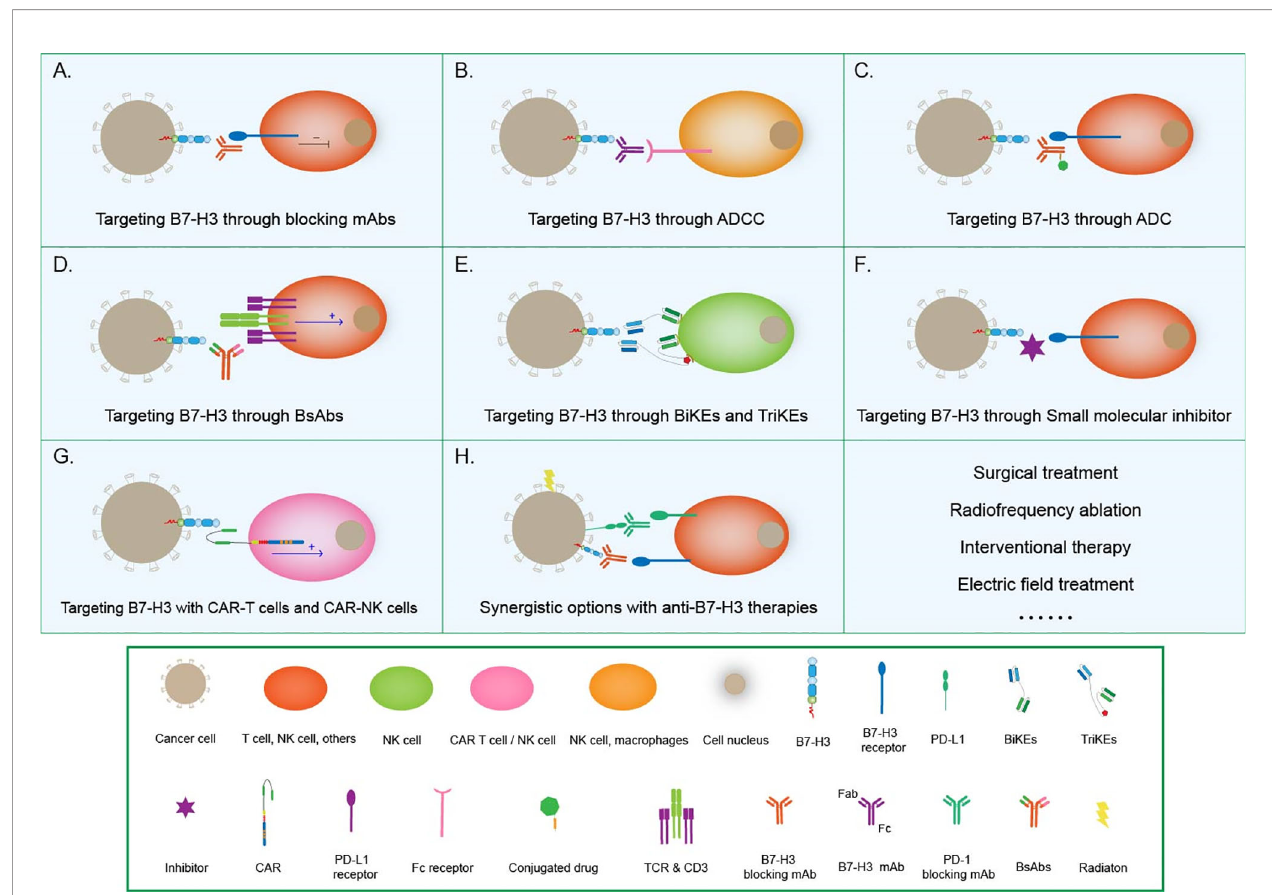
FIGURE 4 | Tumor immunotherapy strategies based on B7-H3. (A) Targeting B7-H3 with blocking mAbs; (B) Targeting B7-H3 through ADCC; (C) Targeting B7-H3 through ADC therapies; (D) Targeting B7-H3 with CD3-engaging BsAbs; (E) BiKEs and TriKEs; (F) Targeting B7-H3 with small-molecule inhibitors; (G) Targeting B7- H3 with CAR T cells and CAR-NK cells; (H) Synergistic options with anti B7-H3